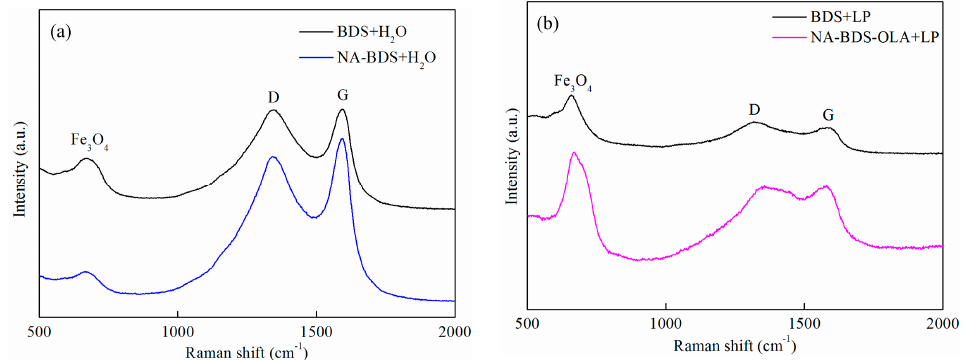
Figure 12. Raman spectra of the worn surfaces of upper balls lubricated using ( a ) BDS + H 2 O and NA-BDS + H 2 O, and ( b ) BDS + LP and NA-BDS-OLA + LP.